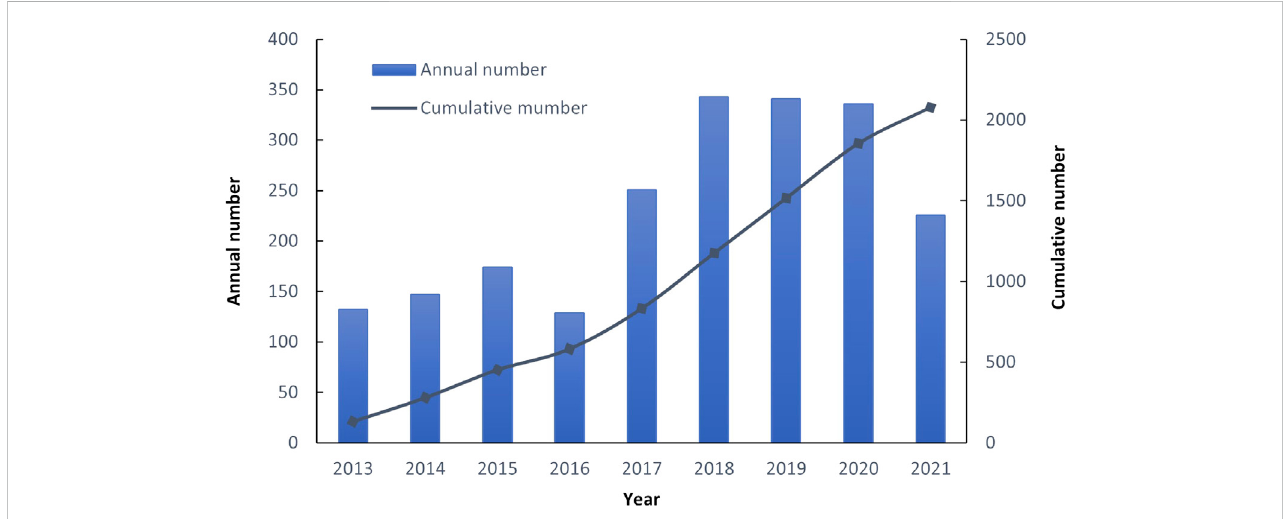
FIGURE 1 Issued number of MSW policies in China from 2013 to